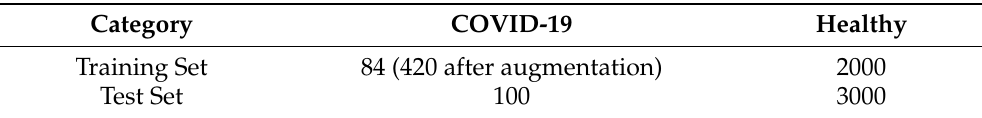
Table 1. Summary of the employed